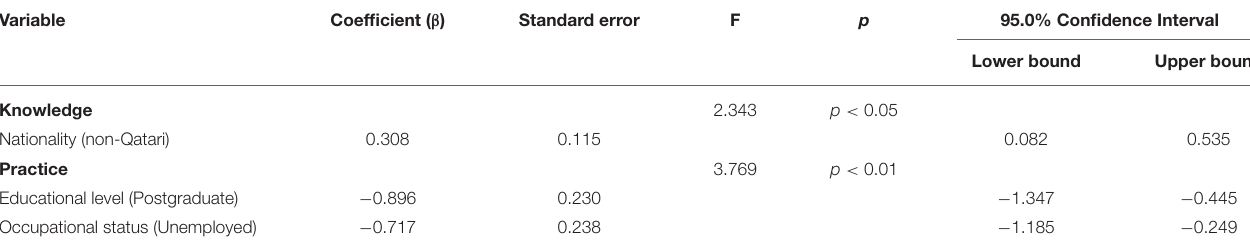
TABLE 5 | Results of significant multiple linear regression on factors associated with COVID-19 knowledge and